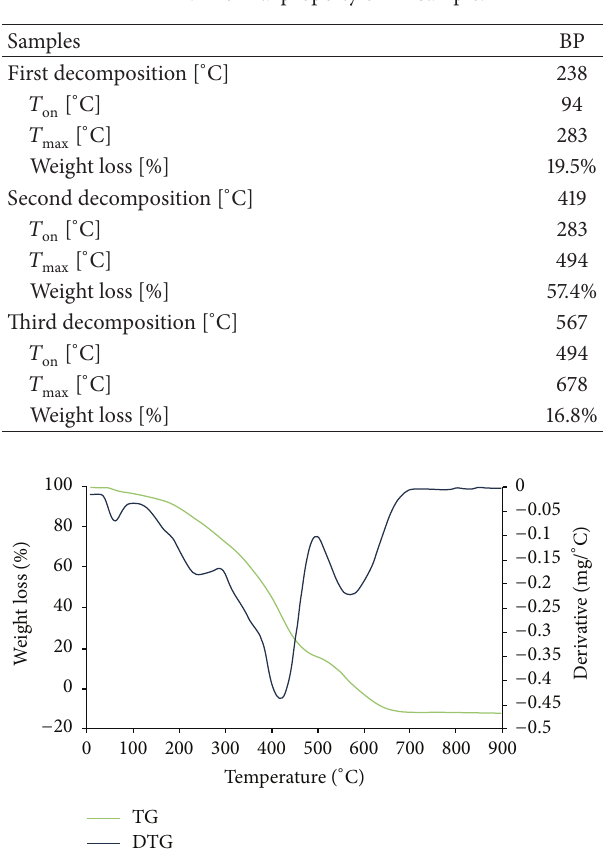
Table 1: Thermal property of BP sample.